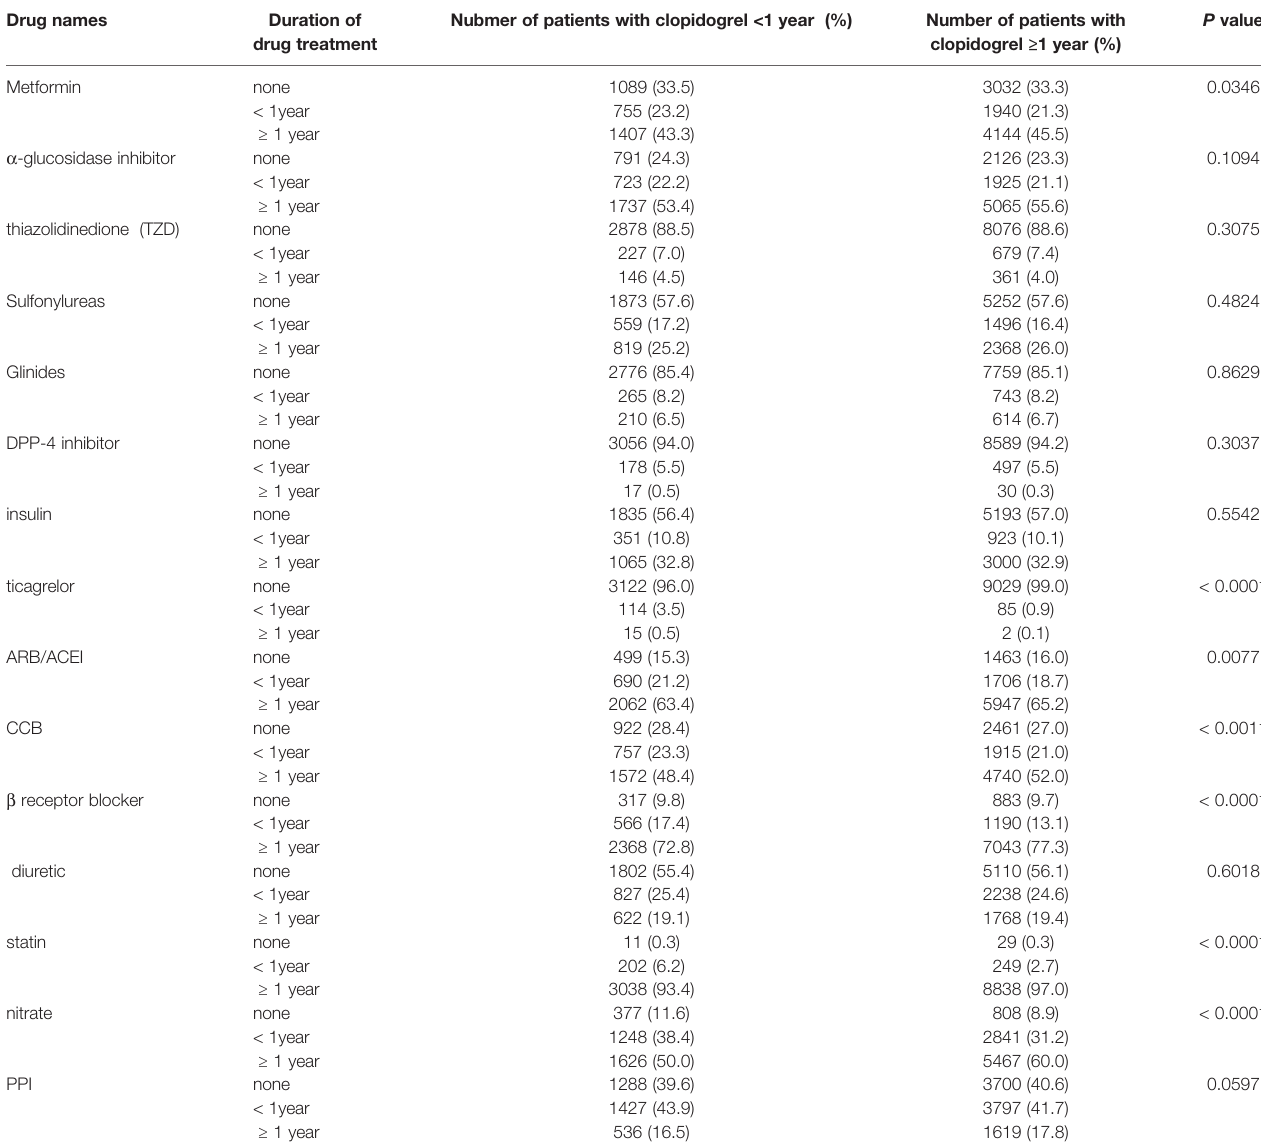
TABLE 1 | Demographics of drug treatment. Drug names Duration of drug